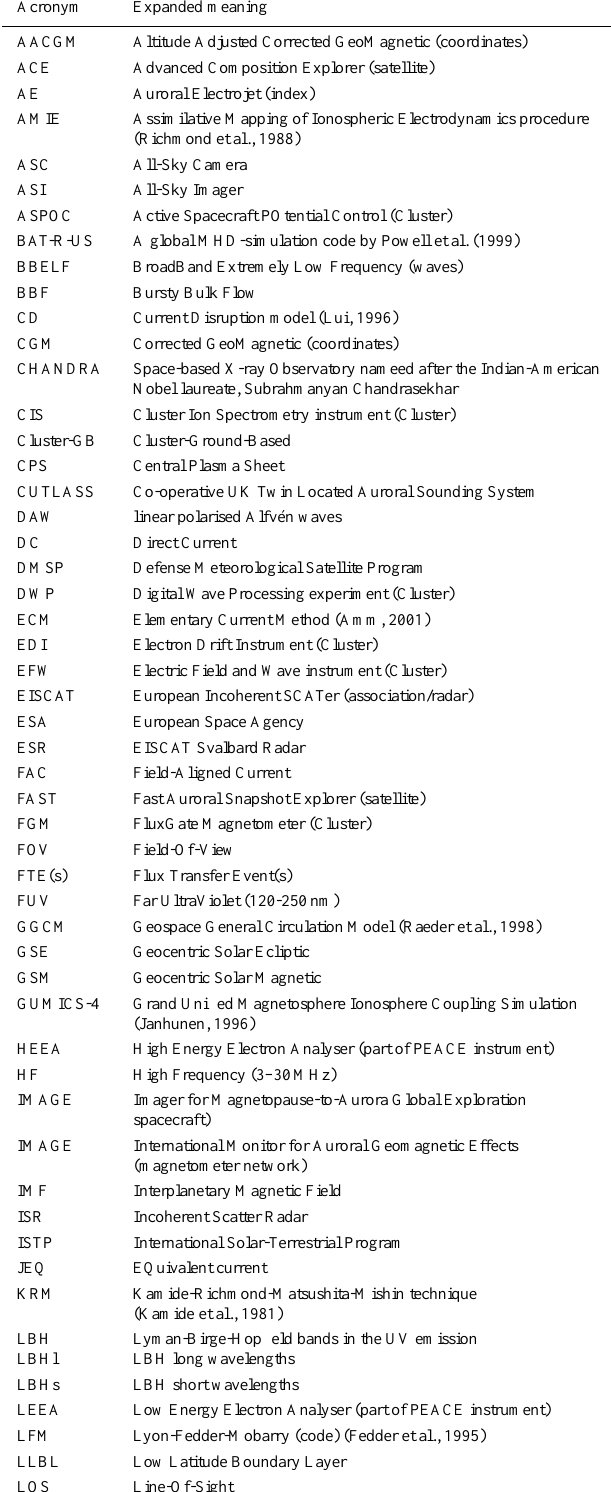
Table 2. List of used acronyms and their